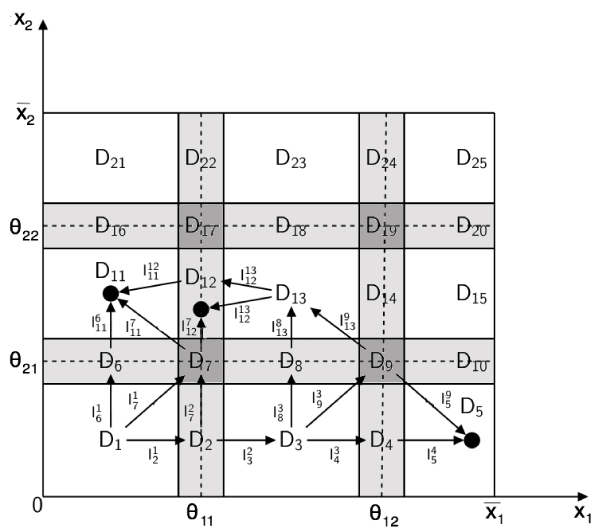
Representation of the qualitative trajectories in the phase space. Phase space representation of trajectories defined by BT(D1) in Fig. 4, filtered of the spurious behaviors QB2 and QB11. Stable states are denoted by ·. The labels  denote the sets of inequalities on parameter values that hold when transitions from Di to Dk occur.